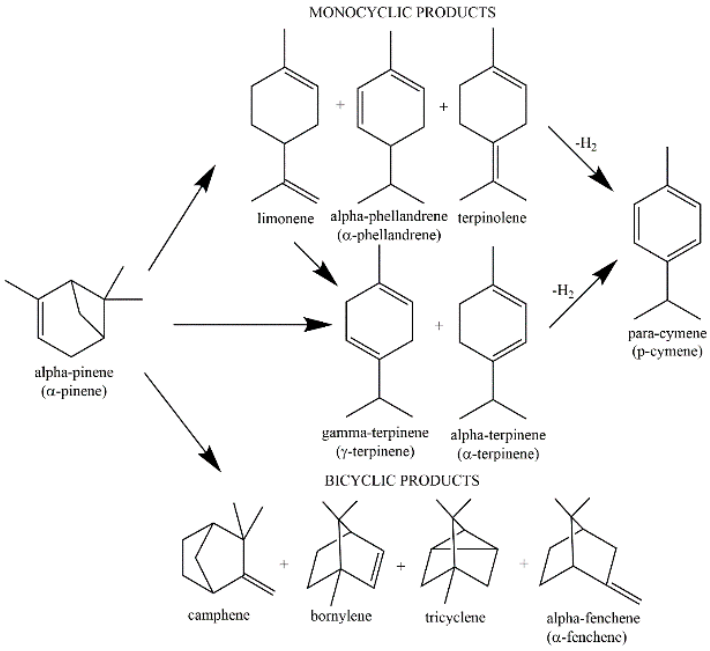
Figure 1. Main products of α -pinene isomerization process and paths of their formation.